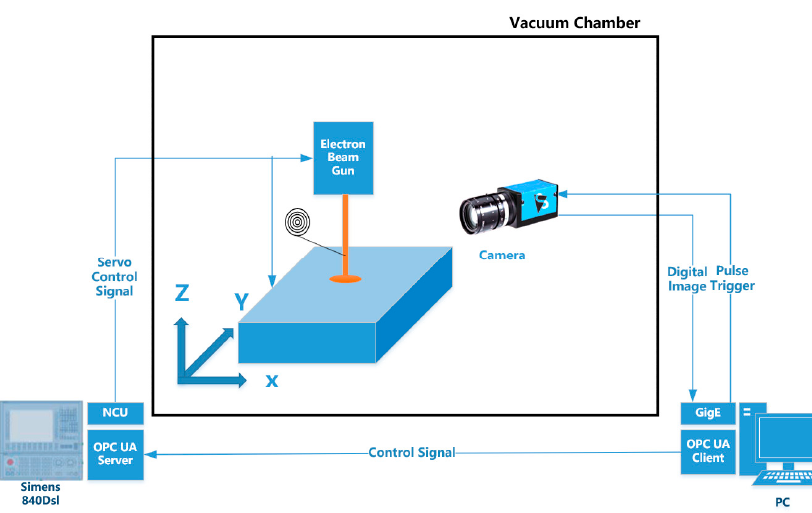
Figure 8. Composition of the closed-loop control system. Sensors 2019 , 19 , x FOR PEER REVIEW Figure 6. Composition of the closed-loop control system.